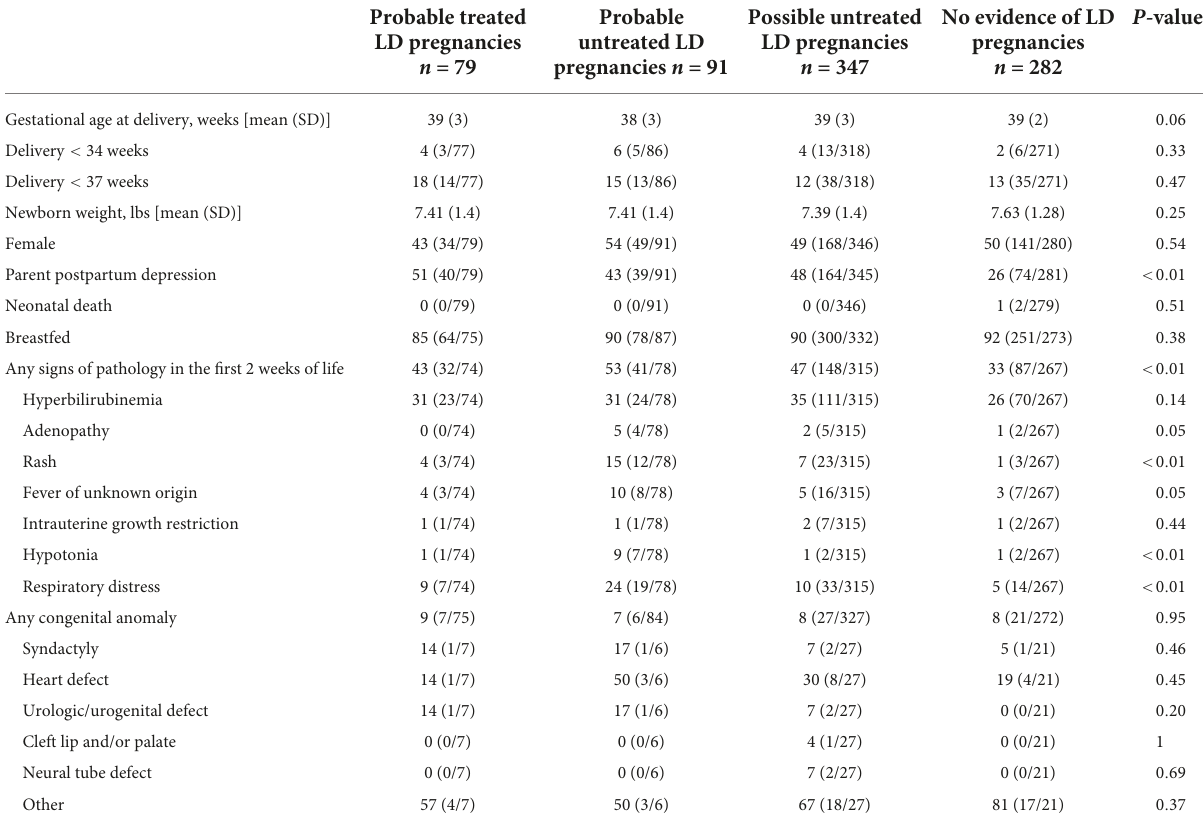
TABLE 5 Postpartum and newborn outcomes by participant/parent LD